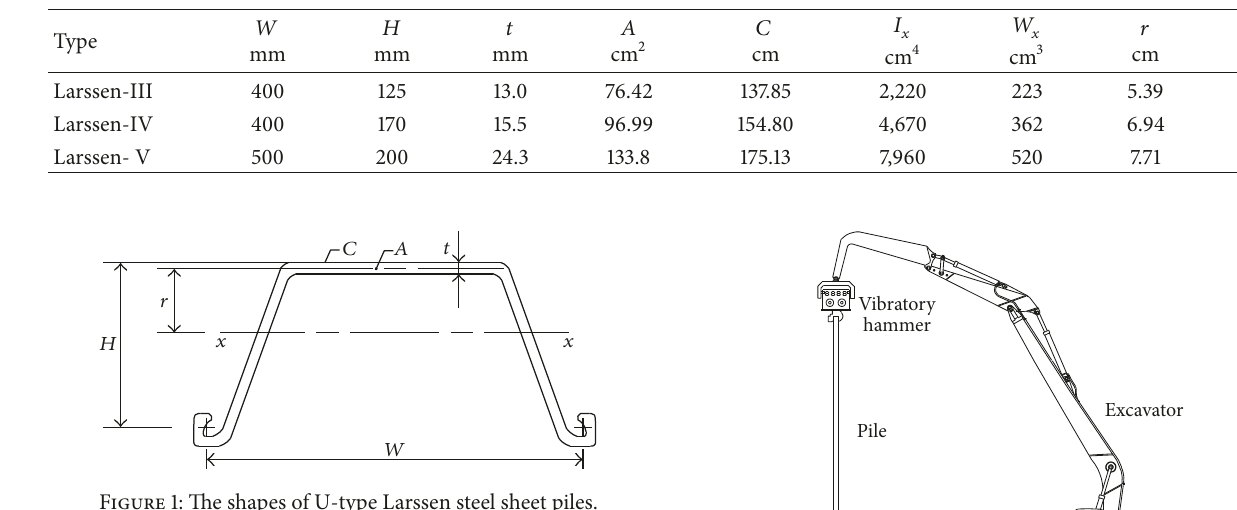
Table 2: Dimensions and sectional properties for steel sheet piles chosen in test.